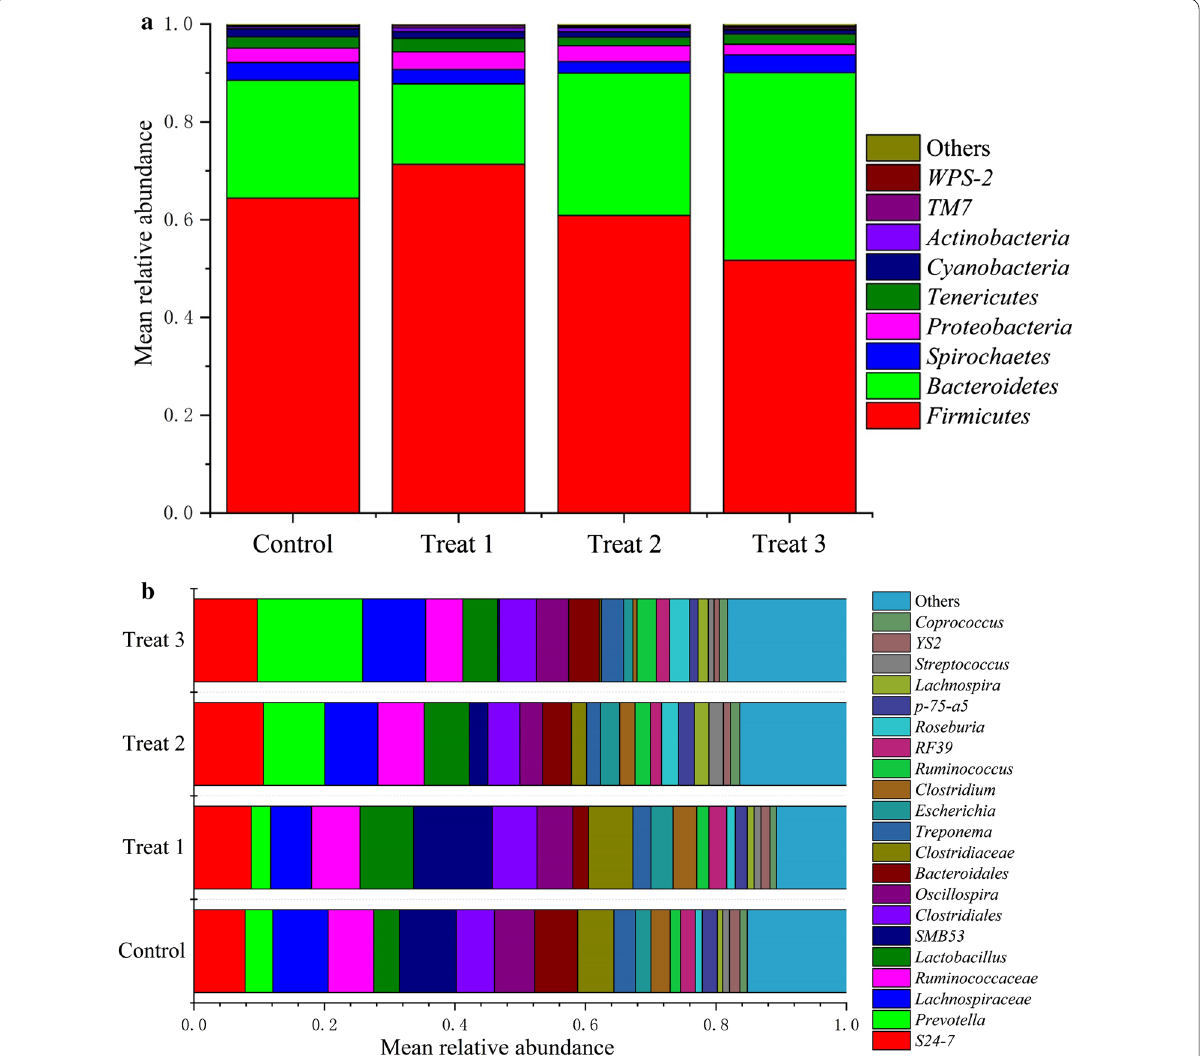
Fig. 2 Taxonomic compositions of gut bacterial communities with different dietary treatments with fermented Mao-tai lees in pigs. a The relative abundance of bacterial phyla. b Their relative abundance of top 21 bacterial taxa within a group at genus